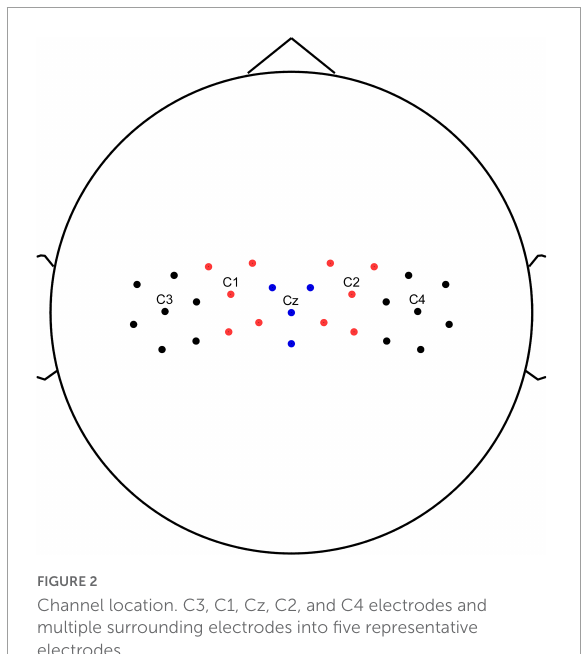
FIGURE2 Channel location. C3, C1, Cz, C2, and C4 electrodes and multiple surrounding electrodes into five representative